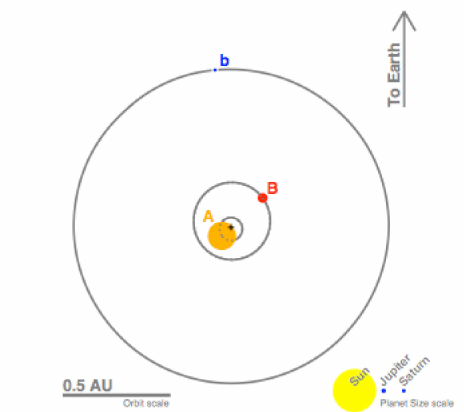
Figure 19. Scale diagram of the Kepler-16 system [166]. Gray curves represent the current orbits. The sizes of the bodies (including the Sun, Jupiter and Saturn) are in the correct proportions to one another, but they are on a scale 20 times larger than the orbital distance scale. The binary and circumbinary planet orbital planes lie within 0.4 ◦ degree of each other, so the orbits are essentially flat. The planet’s orbital eccentricity is nearly zero, while the orbital eccentricity of the binary star system is about 0.16. Symbol “+” marks the center of mass of all three